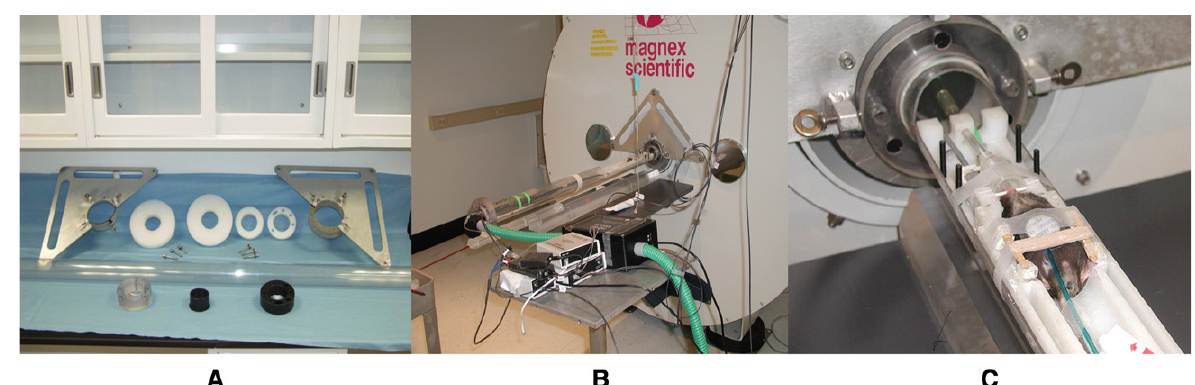
Figure 1. (A) Major parts of the positioning system. (B) Positioning system in place. (C) Mouse positioned supine in the stereotaxic cradle system which fi ts into the positioning tube that secures the RF volume coil in